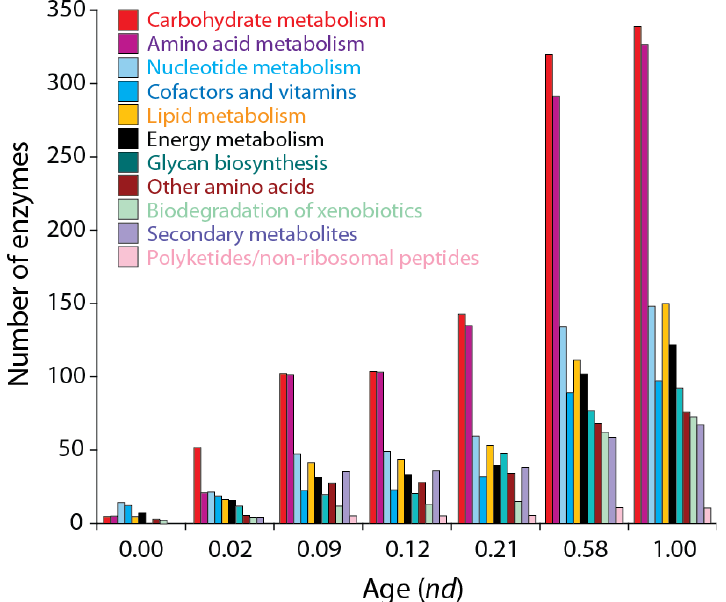
Figure 4: Evolutionary accumulation of enzymes in mesonetworks of KEGG. The plot shows the cumulative number of core mesonetwork enzymes appearing in the timeline, with age suitably binned in nd